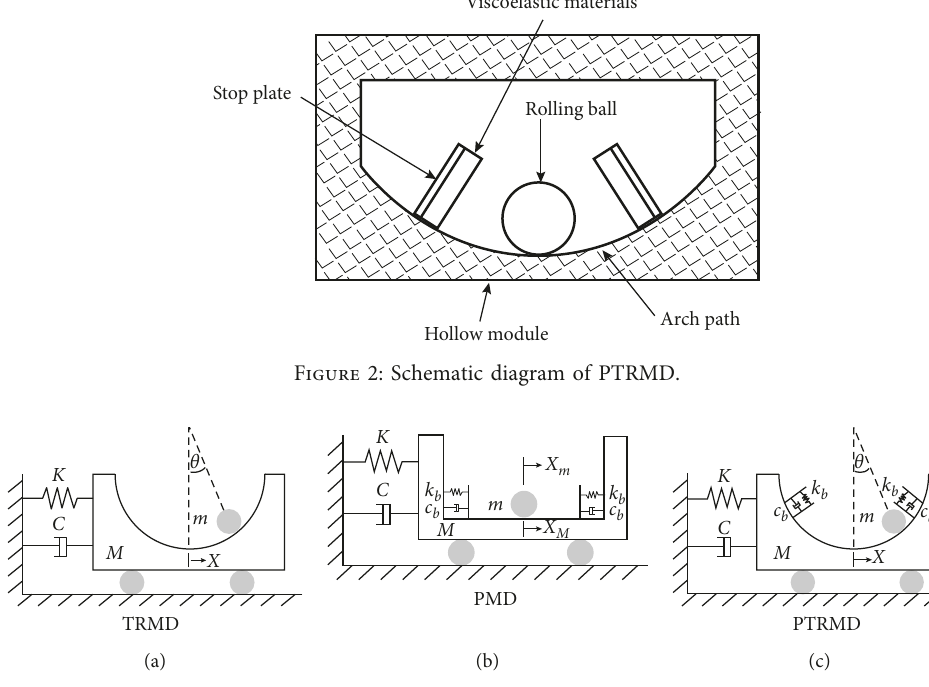
Figure 3: Schematic diagram of the physical model of a (a) TRMD, (b) PMD, and (c) PTRMD.